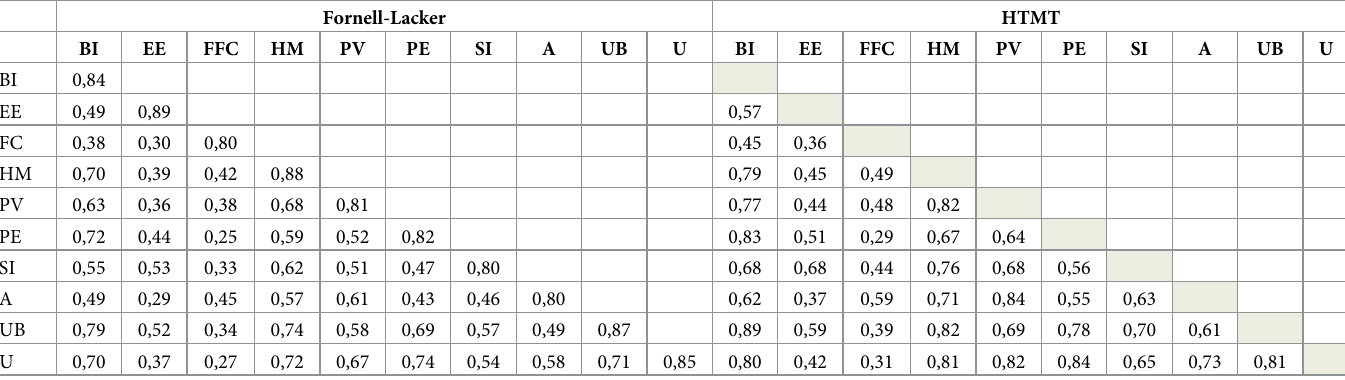
Table 2. Fornell-Lacker and HTMT discriminant validity analyses.